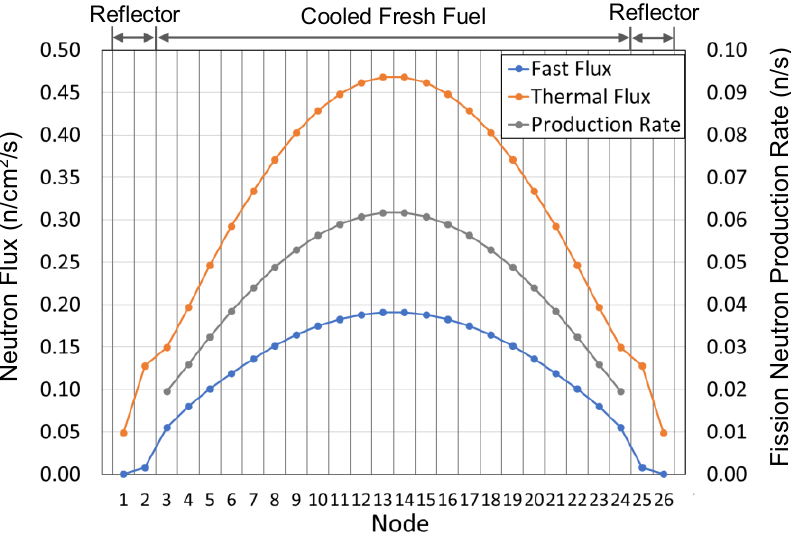
Figure 4. Reference Node-averaged Neutron Fluxes and Node-integrated Fission-Neutron Production Rates for the Steady-state Configuration